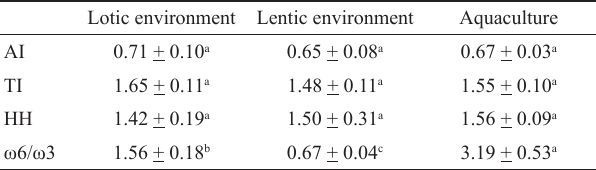
Tab. 4. Nutritional quality assessment of Lophiosilurus alexandri from lotic and lentic environments and aquaculture. Mean ± standard deviation (n=5) followed by different letters to each other ( P <0.05). AI= Atherogenic index, TI= Thrombogenecity index, HH= ratio between hypocholesterolemic and hypercholesterolemic fatty acids and ω6/ω3 =